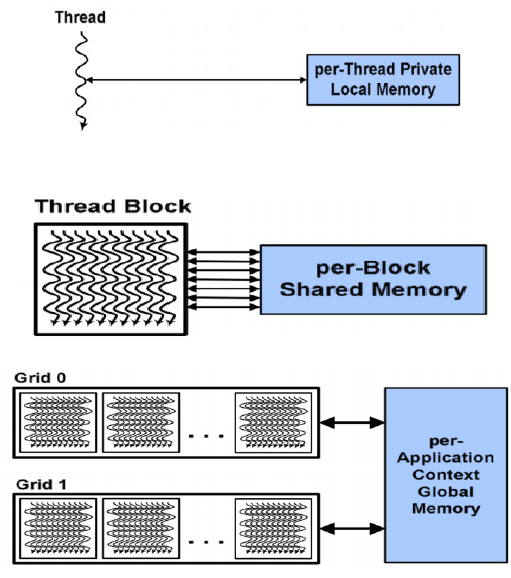
Figure 1 . Architecture of the CUDA program and these